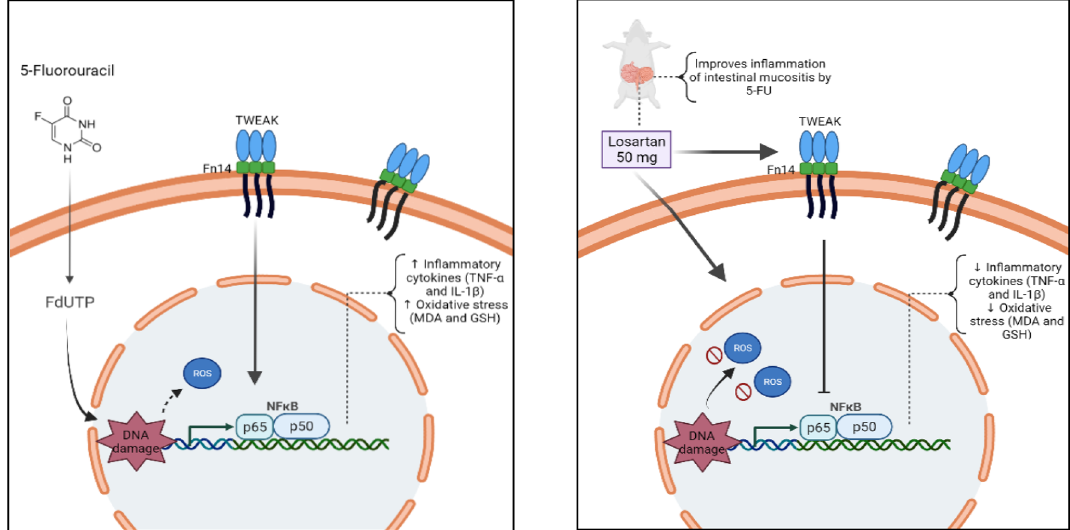
Figure 7. Representation of pharmacological modulation of the intestinal mucositis induced by 5-fluorouracil (5-FU) treated with the losartan. DNA damage due to 5-FU promotes the release of reactive oxygen species (ROS) and activates NF-κB that induces the expression of proinflammatory cytokines such as IL-1β and TNF-α, in addition, occurs the oxidative stress, which that together promote inflammation in the intestinal mucosa. Losartan was reducing NF-κB p65 in response the decreased of gene expression TWEAK/Fn14, reducing IL-1β and TNF-α and decreasing oxidative stress, therefore improving intestinal mucositis. TWEAK, Tumor necrosis factor (TNF)-like weak inducer of apoptosis; Fn14, Fibroblast growth factor-inducible 14; NF-κB p65, nuclear transcription factor kappa